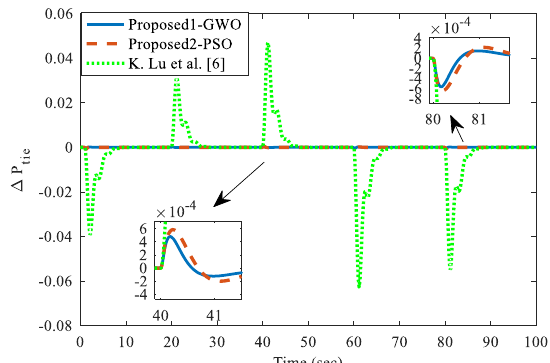
Fig. 24 Tie-line power flow between two areas for case 5e under case study 5